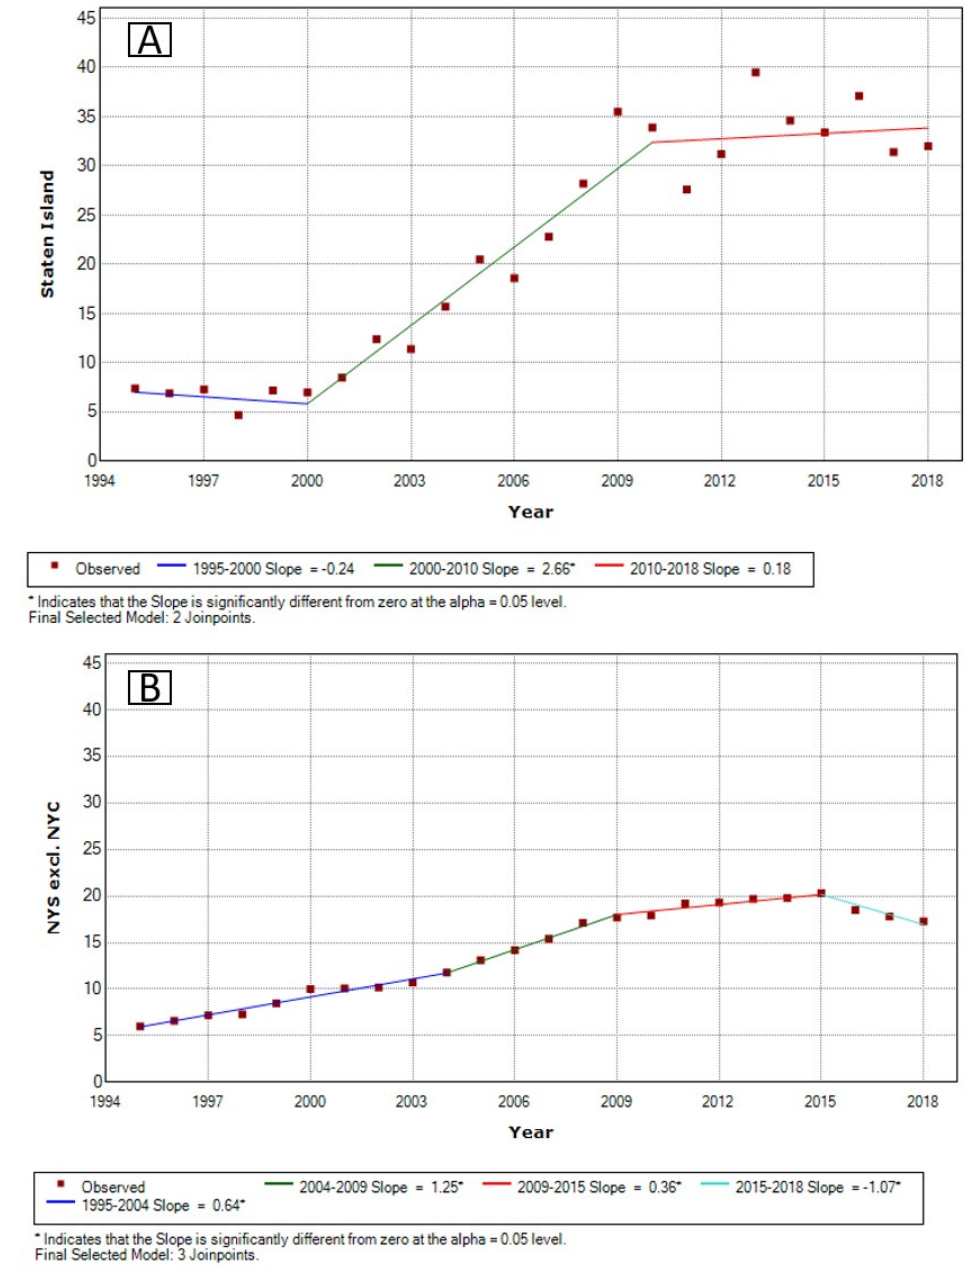
Figure 2. Annual percent change in age-adjusted thyroid cancer rates on Staten Island ( A ) and NYS excluding NYC ( B ) between 1995 and 2018.